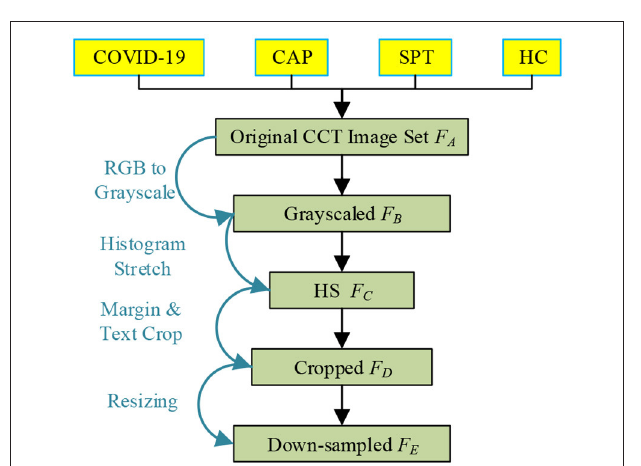
FIGURE 3 | Samples of four categories ( k